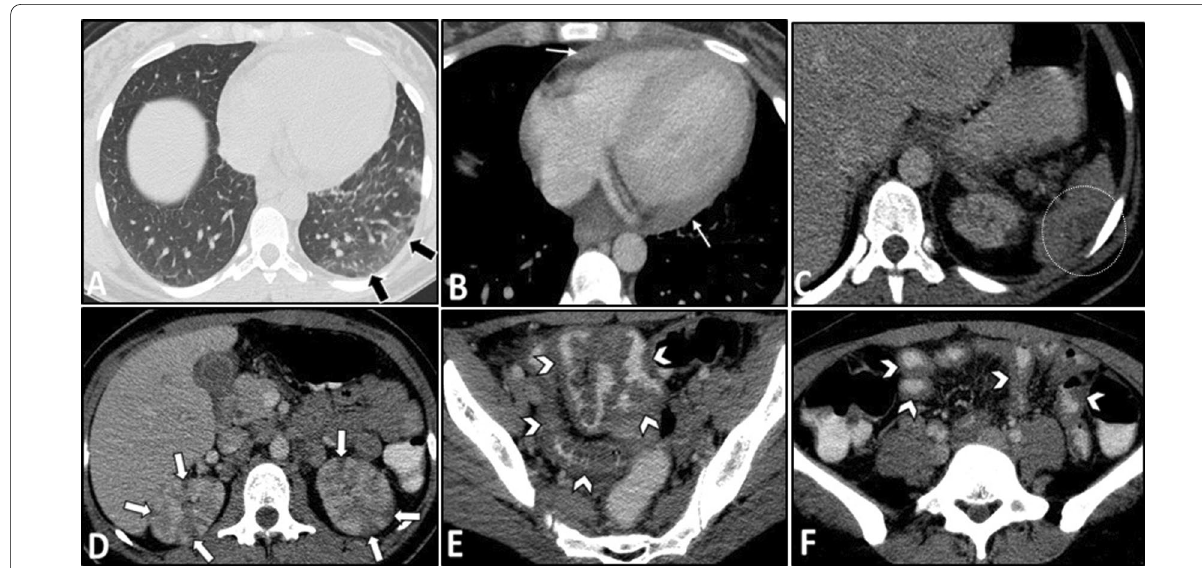
Fig. 16 Intestinal vasculitis and renal infarction in a 29-year-old female with known SLE presenting with fever, malaise, generalized abdominal pain, dyspnea, and elevated ESR. An abdominopelvic CT scan with IV and oral contrast was done. There are subpleural patchy areas of GGO at the left lower lobe suggestive of lupus pneumonitis (thick black arrows in A ). Small pericardial effusion and thickening (thin white arrows in B ) are seen in favor of serositis. There is a wedge-shaped subcapsular hypodensity in the spleen (white dotted oval in C ), indicative of splenic infarction. Multiple bilateral wedge-shaped renal parenchymal infarcts are also depicted (thick white arrows in D ). Diffuse circumferential wall thickening of ileal loops (white arrowheads in E and F ) is evident, representing lupus